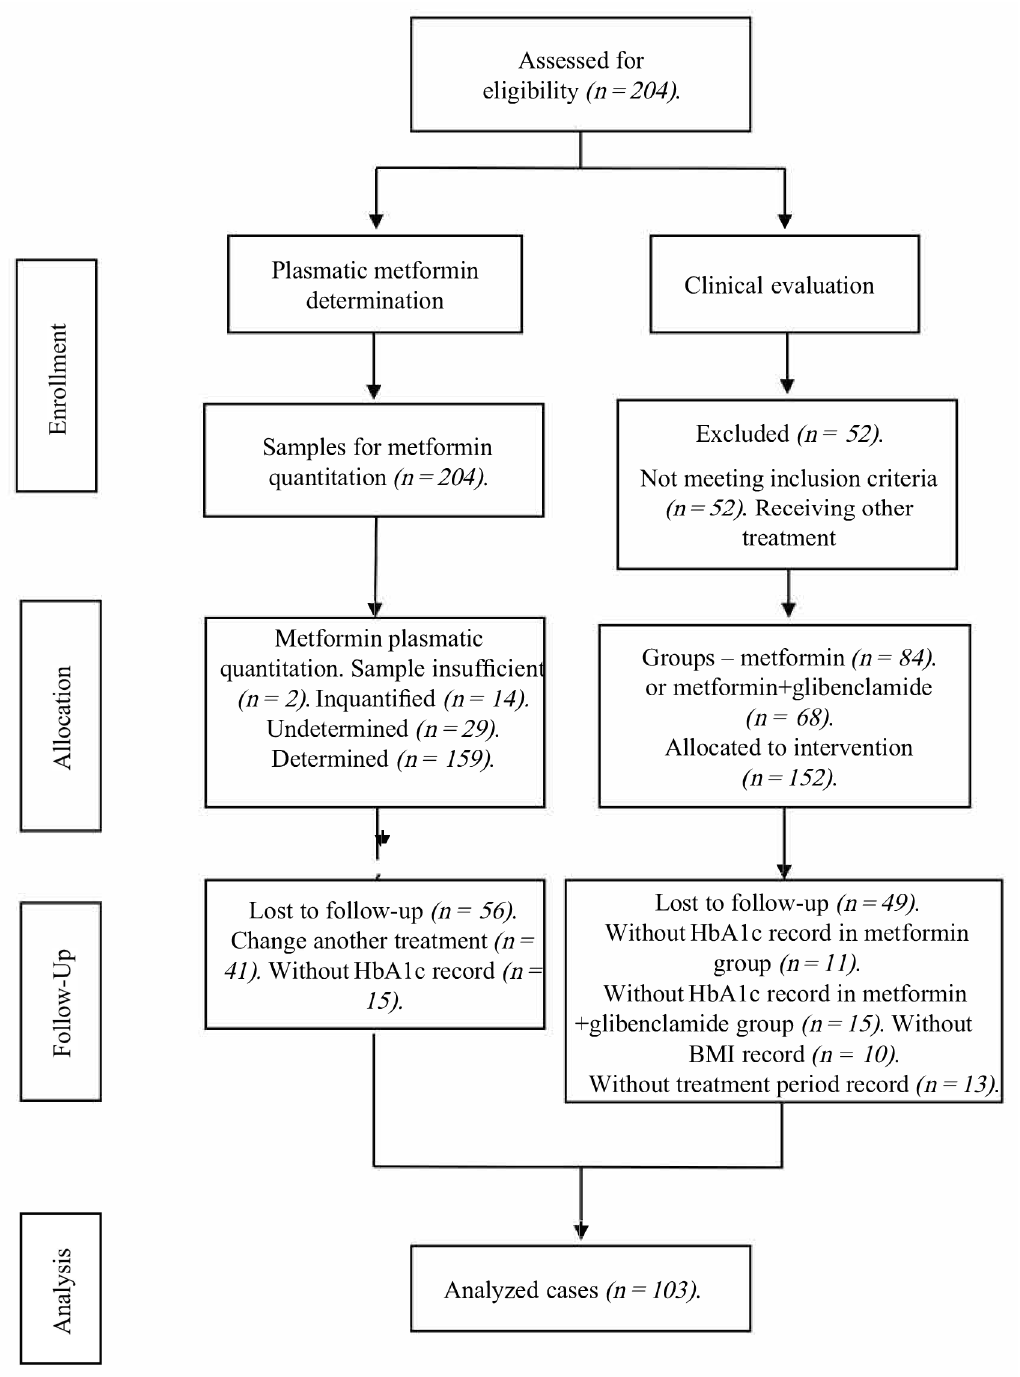
Scheme 1. CONSORT flow diagram of the trial